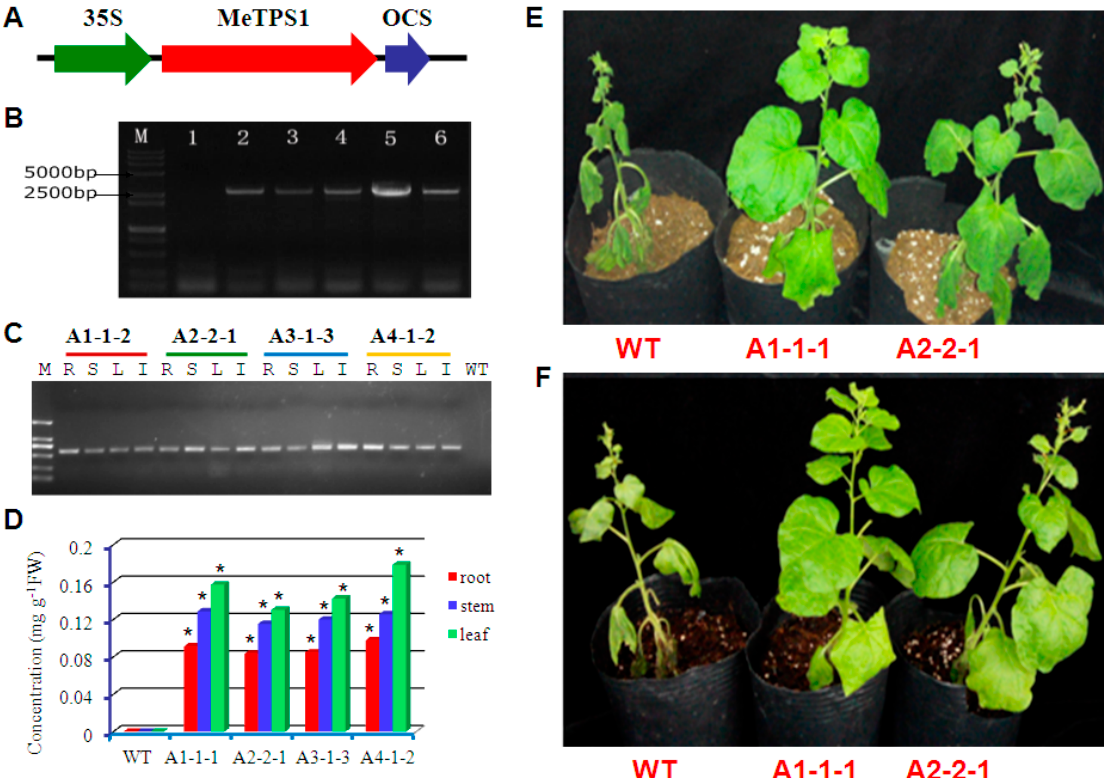
Figure 7. Functional analysis of MeTPS1 gene by transforming it into tobacco: ( A ) MeTPS1 gene was inserted in the plant expression vector pCAMBIA2300 under the control of CaMV35S promoter; ( B ) PCR verification of transgenic tobacco plants ( Nicotiana benthamiana ) (Lanes: M, molecular weight marker; 1, wild type tobacco; 2, A1; 3, A2; 4, A3; 5, A4; 6, pCAMBIA2300 - MeTPS1 ); ( C ) RT-PCR analysis of MeTPS1 gene in homozygous transgenic lines (Lanes: M, molecular marker; R, root; S, stem; L, leaf; I, inflorescence; WT, wild-type control); ( D ) trehalose concentrations in homozygous transgenic lines, where * indicates significant differences at 1% level of significance compared to the relevant organ of wild type (WT); ( E ) representative transgenic plants and wild-type (WT) after 30 days of water-withheld; and ( F ) the same plants as in ( E ) one day after re-watering.